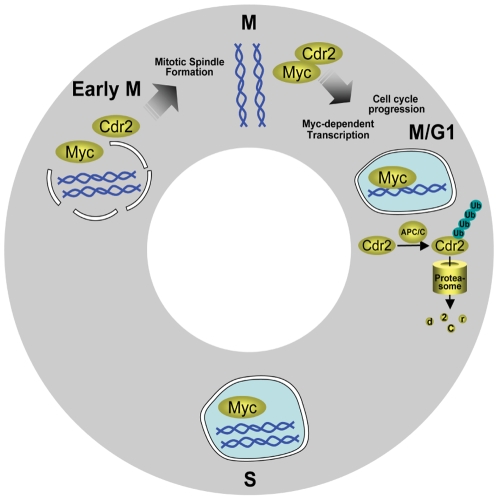
Model of cdr2 action in mitosis.Cdr2 levels increase in G2, peak in mitosis and decrease as cells exit mitosis. Nuclear envelope breakdown in prometaphase allows newly synthesized cdr2 access to c-myc protein, which, like other transcription factors [61], partitions itself off DNA during chromatin condensation, coinciding with mitotic shutdown of transcription. Cdr2 colocalization with c-myc is first apparent during metaphase (Figs. 4C, 5D) and peaks during telophase/cytokinesis (Fig. 4F) after which c-myc relocalizes to the nucleus (Figs. 4D, 5E). During late mitosis/early G1, cdr2 KEN and D boxes are recognized by the APC/C, which ubiquitinates cdr2, targeting it for degradation by the proteasome. Cdr2 knockdown cells show defects in mitotic spindle formation, cell cycle progression and c-myc-dependent transcription. Based on our current results, and the observations that cdr2 is preferentially phosphorylated during G1 but not mitosis [51], and that a smaller migrating, possibly dephosphorylated, isoform of cdr2 interacts with c-myc in vivo
[11], we hypothesize that unphosphorylated cdr2 interacts with c-myc to prevent c-myc degradation, thereby allowing subsequent c-myc-dependent transcription of genes to occur upon resumption of transcription following mitosis. At this point phosphorylation of cdr2 leads to recognition by the APC/C, targeting it for degradation by the proteasome. In tissue culture, overexpression of cdr2 may lead to several effects, including aberrant sequestration of c-myc and inhibition of c-myc activity [11]. Taken together, the data suggest an overall hypothesis, in which that cdr2 action on c-myc leads to a concerted action on target genes to promote cellular proliferation, and that this action is inhibited by cdr2 knockdown. Disruption of cdr2:c-myc control may therefore disrupt mitotic exit and impact the growth of cdr2-expressing tumors.